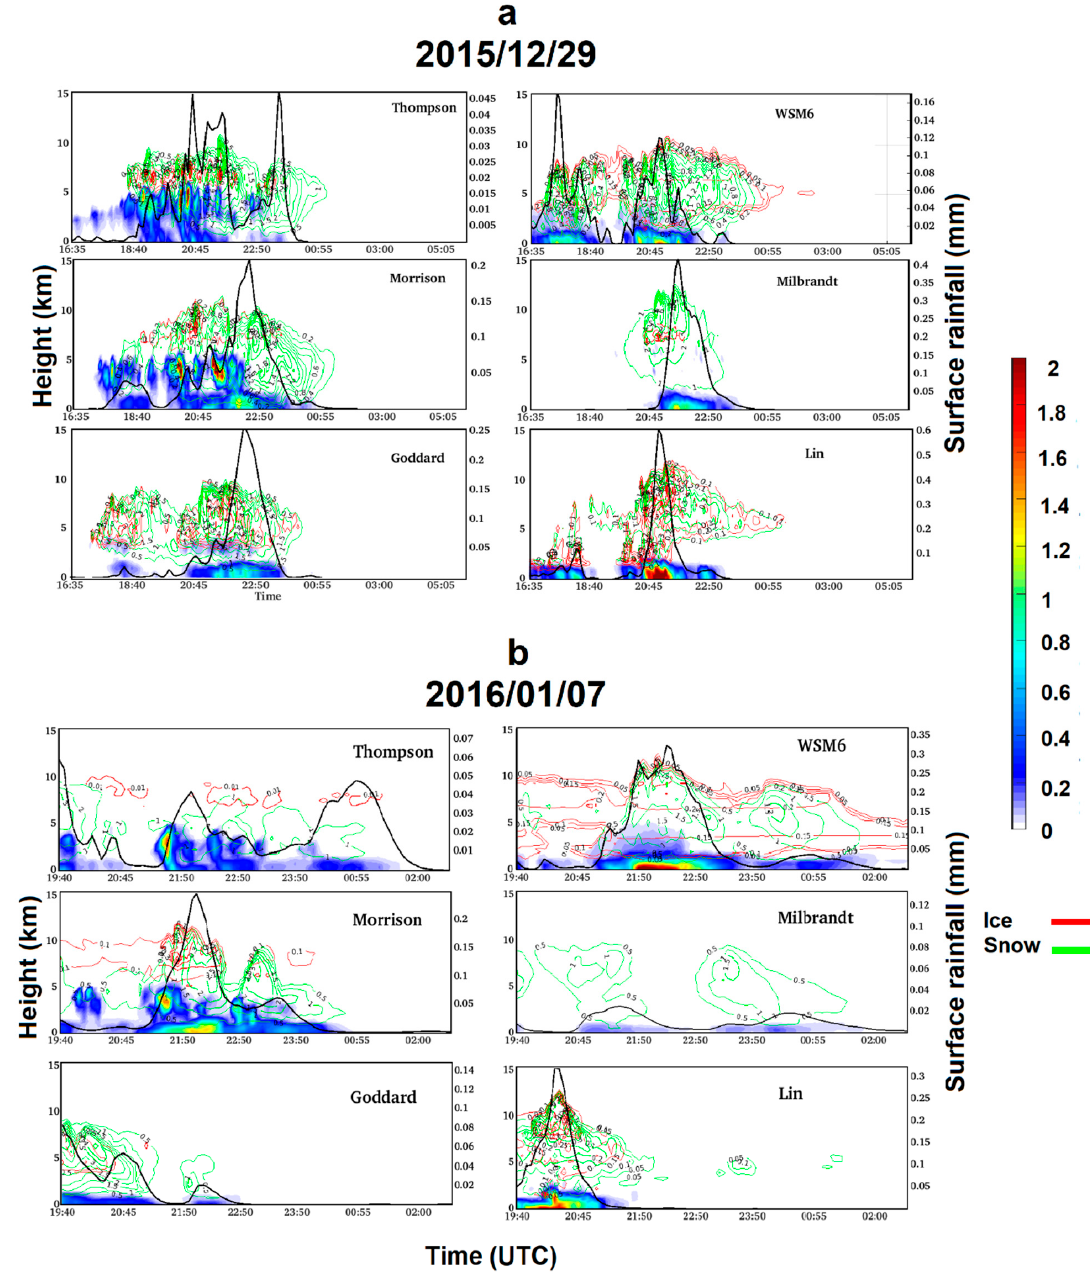
Figure 11. Temporal evolution of the average rain mass (shaded) with altitude for convective rainfall events. Contour lines show the mixing ratio for ice (red) and snow (green) for convective rainfall events. The averaging area is a 10 × 10 m square centered in HYO. ( a ) CRE1. ( b ). CRE2